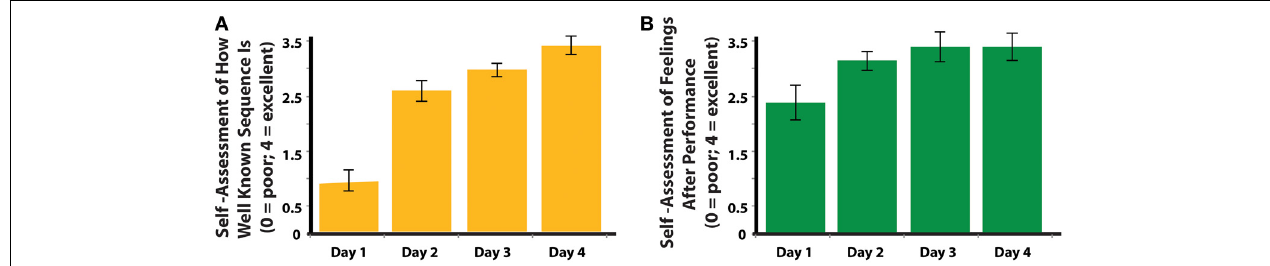
FIGURE 3 | Self-assessment by participants in the physical training group, collected each day after physical practice. (A) Participants’ assessment of how well they thought they knew the sequences they just performed. (B) Participants’ assessment of how they felt after each day of training.